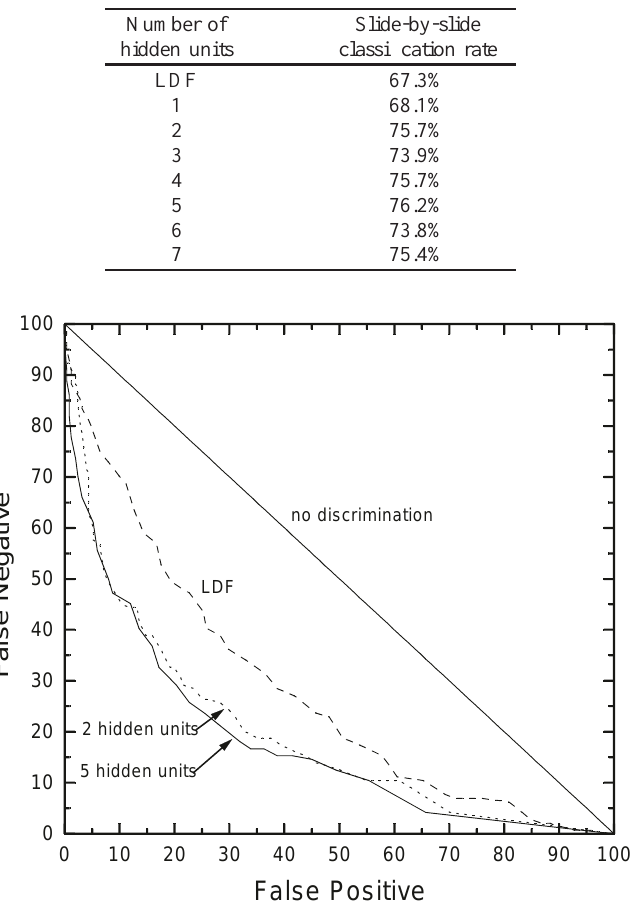
Table 3 The slide-by-slide classification rates of the best cell classifiers are shown for the neural networks with different numbers of hidden units. These are the jackknife results for a set of 251 normal slides and 144 slides con-